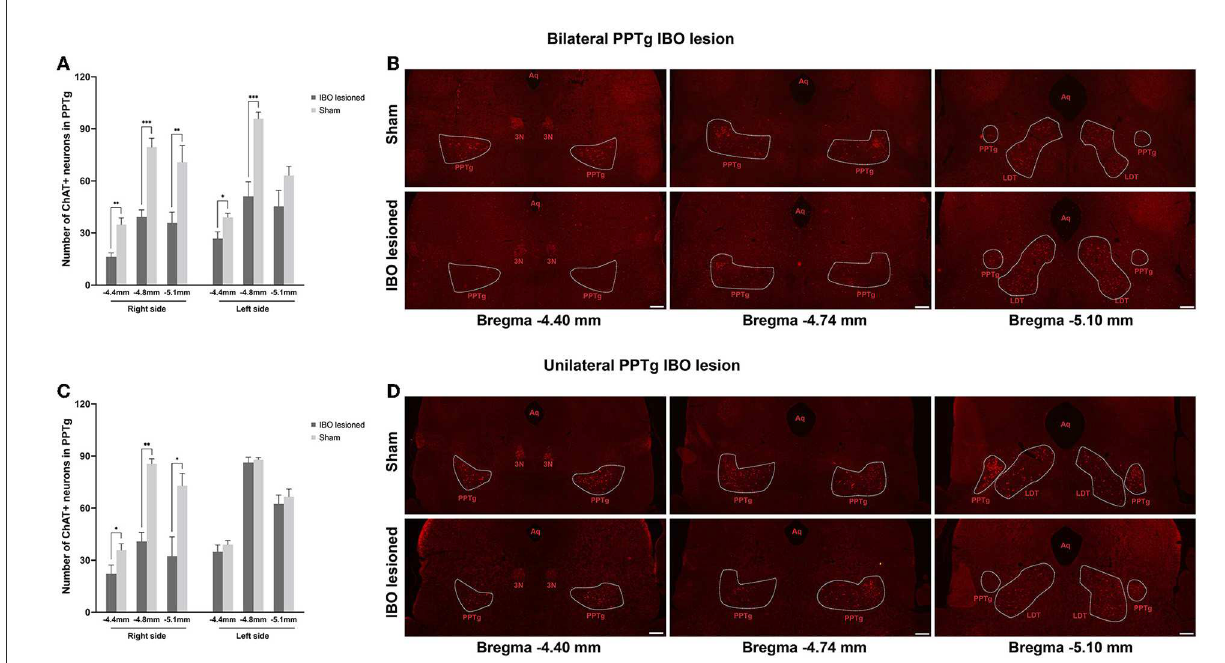
FIGURE3 Quantification of cholinergic neurons and lesion analysis in different layers of the PPTg for mice that underwent bilateral and unilateral PPTg IBO lesion. (A) The comparison of the absolute number of cholinergic neurons in the anterior ( ∼ AP − 4.4mm), central ( ∼ AP − 4.8mm), and posterior ( ∼ -5.1mm) PPTg between the bilateral IBO lesioned and sham lesioned mice. (B) Representative photographs of ChAT staining of the anterior, central, and posterior PPTg for the bilateral IBO and sham lesioned mice. (C) The comparison of the absolute number of cholinergic neurons in the anterior ( ∼ AP − 4.4mm), central ( ∼ AP − 4.8mm), and posterior ( ∼ -5.1mm) PPTg between unilateral IBO lesioned and sham lesioned mice. (D) Representative photographs of ChAT staining of anterior, central, and posterior PPTg for unilateral IBO and sham lesioned mice. The PPTg is outlined with the dotted line. * P < 0.05, ** P < 0.01, *** P < 0.001. Scale bar = 1000 µ